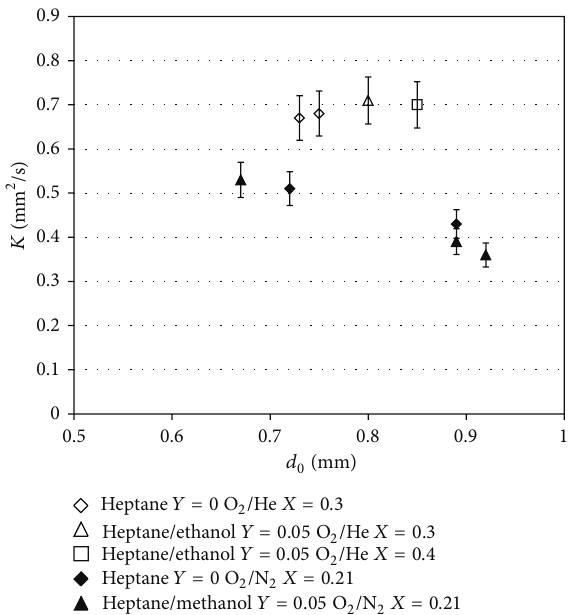
Figure 7: Droplet burning rates 𝐾 as a function of the initial droplet diameter 𝑑 0